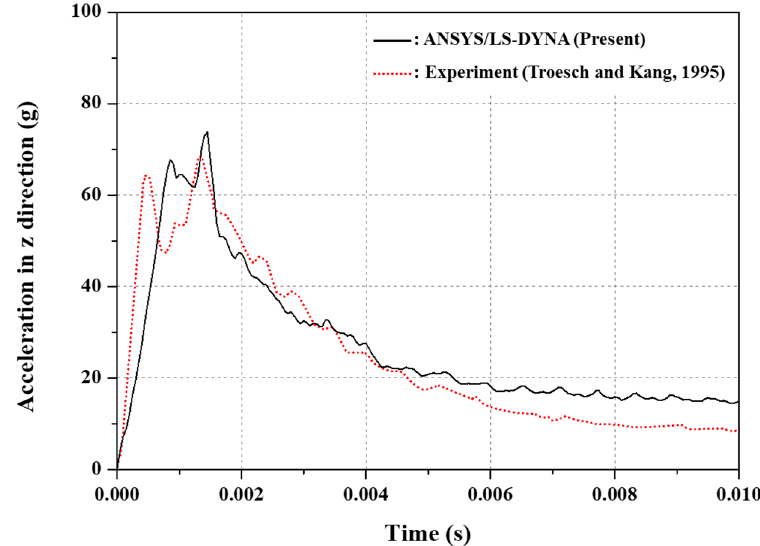
Figure 5. Comparison between test and FSI models.